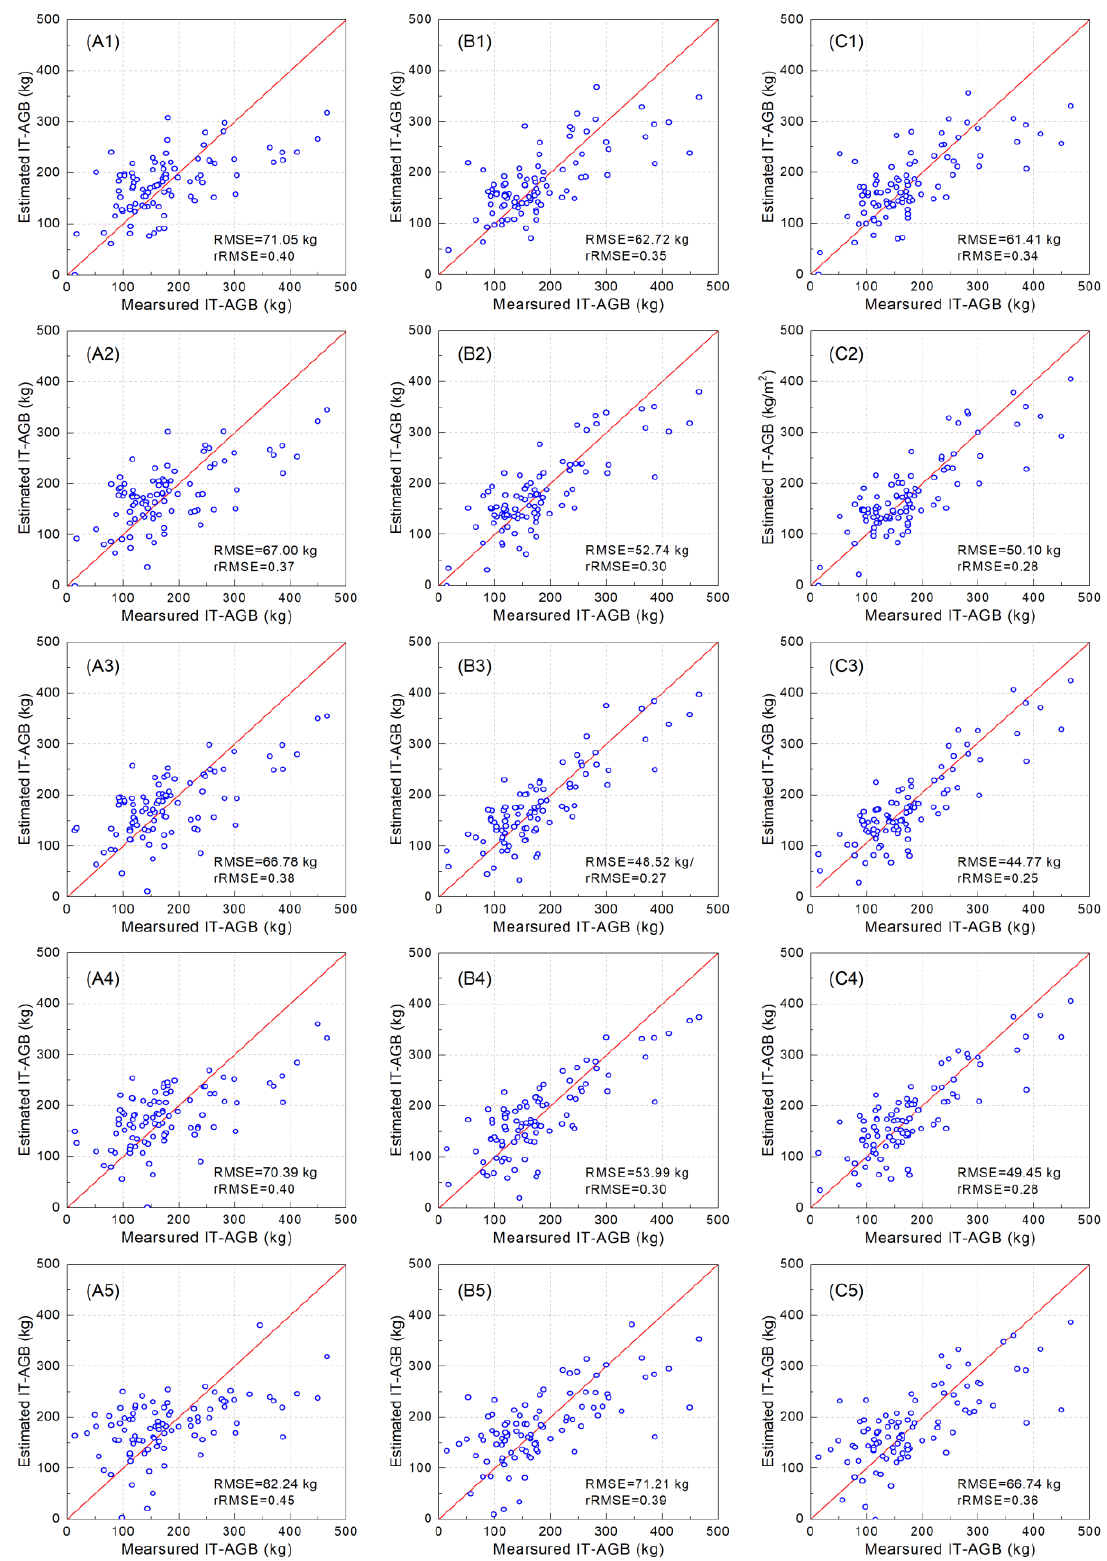
Figure 7. Scatterplots of measured and predicted IT-AGB. Ai, Bi and Ci are models with spatial resolutions of 0.05 m, 0.1 m, 0.2 m, 0.5 m and 1 m, respectively; ( A1 – A5 ) are models of experiment A; ( B1 – B5 ) are models of experiment B; ( C1 – C5 ) are models of experiment C. The red line in the figure is the line of y = x .